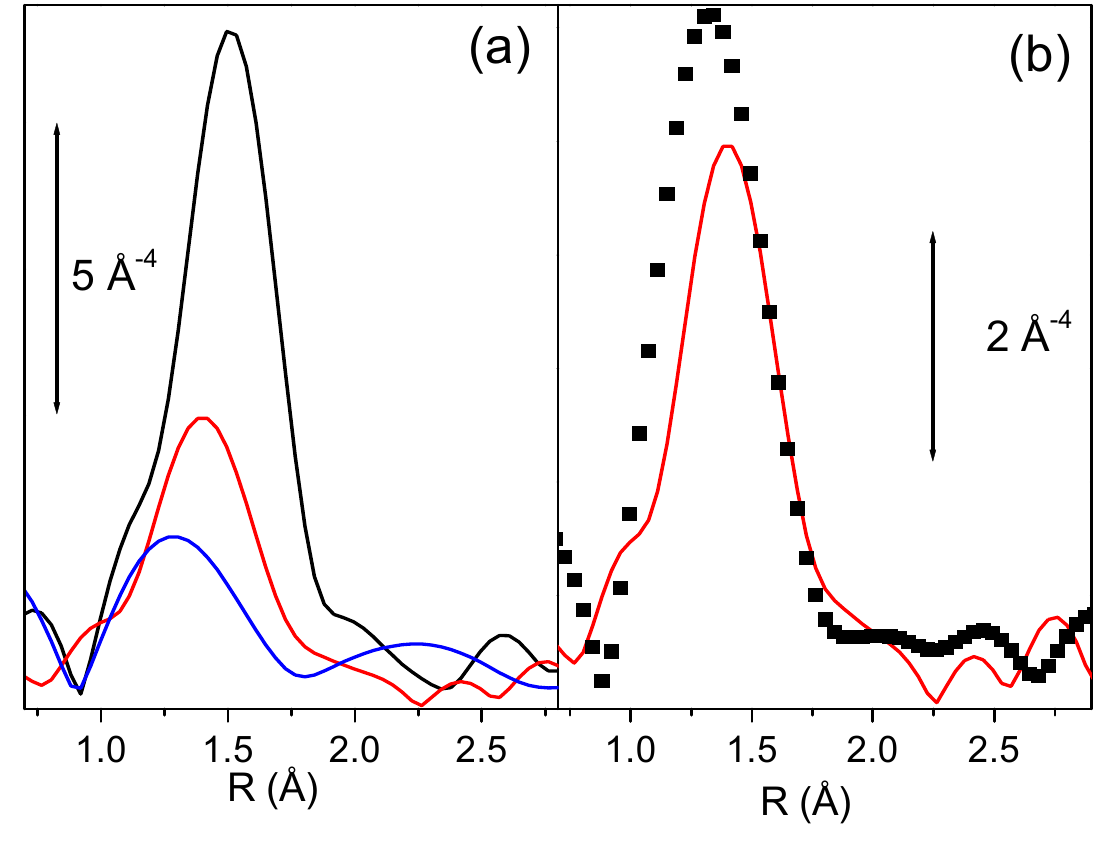
Figure 7: Part (a): k 3 -weighted, phase uncorrected Fourier Transform of the EXAFS functions of Fe-silicalite sample in presence of template (black line), and after activation at 773 and 973 K (red and blue lines respectively). Part (b) as part (a) for Fe-silicalite activated 773 K (reported again for sake of comparison, dotted line) and for the same catalyst after subsequent oxidation in N that the two parts have a different ordinate